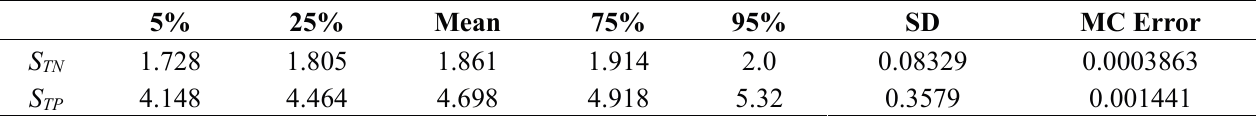
Table 1. The posterior decay rate for TN ( S TN , 1/a) and TP ( S TP , 1/a) and their standard deviations (SD) and Monte Carlo (MC) errors of the Taihu